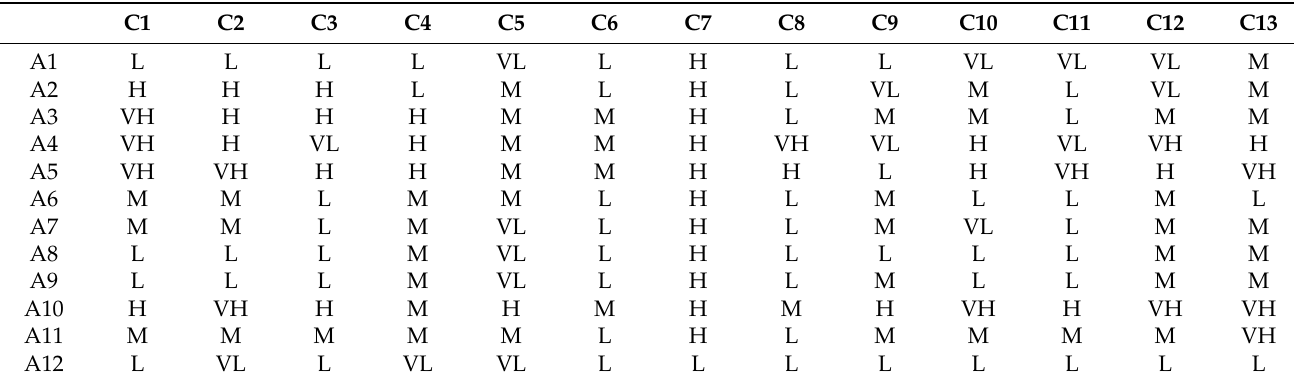
Table A4. Decision maker 2 (cid:48) s linguistic